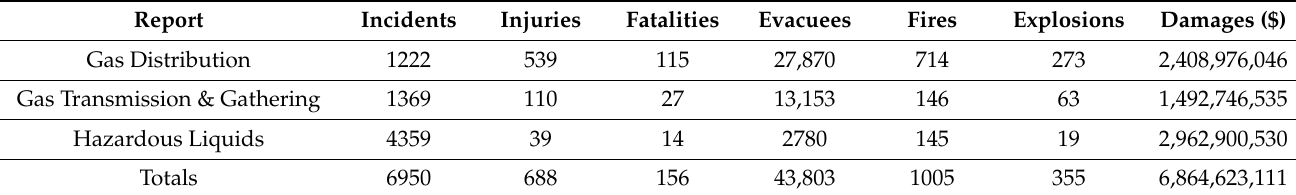
Table 1. Summary of pipeline incidents in the US from 2010 to 2020 (authors’ own processing from PHMSA